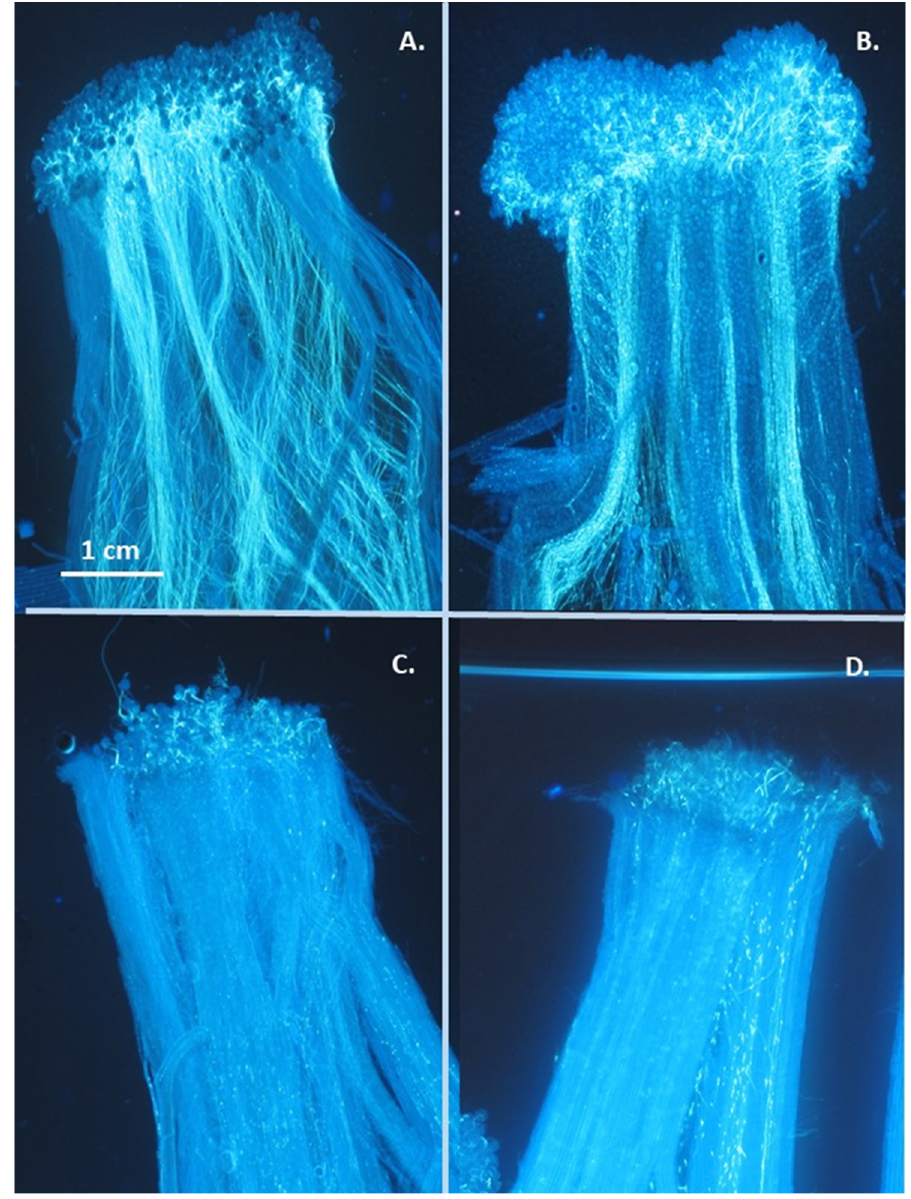
Figure 3. Stigmas of blueberry after different types of pollination (self- or open pollination) and application of TOC or lack of it. ( A ) Open pollination; ( B ) open pollination + TOC; ( C ) self-pollination; ( D ) self-pollination + TOC. TOC—titanium organic complex.